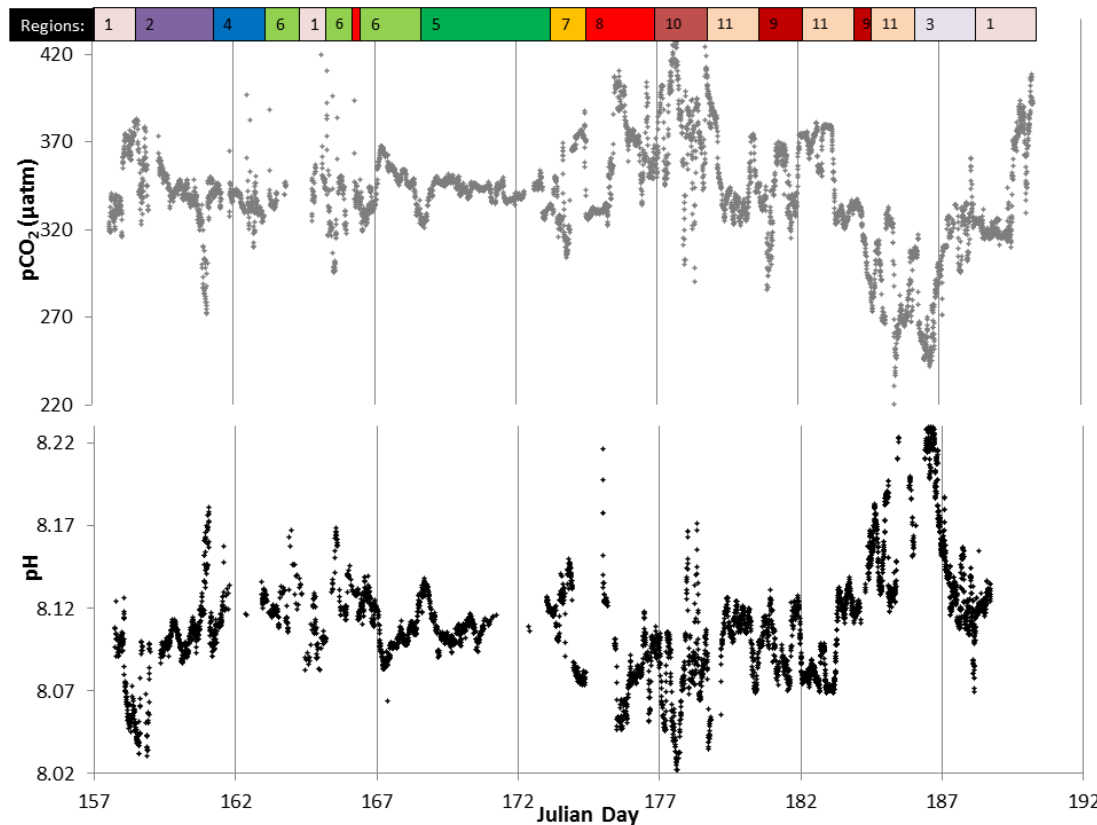
Figure 5. Sea surface pCO 2 and pH tot for the cruise D366 with the variables plotted against Julian Day. Irish Sea (region 1), Malin Sea; northwest of Ireland (region 2), Celtic Sea (region 3), south of Cornwall, UK (region 4), Bay of Biscay (region 5), English Channel (region 6), Southern North Sea (region 7), Central North Sea (region 8), Skagerrak (region 9), Northern North Sea (region 10), South of the Shetland Islands (region 11).